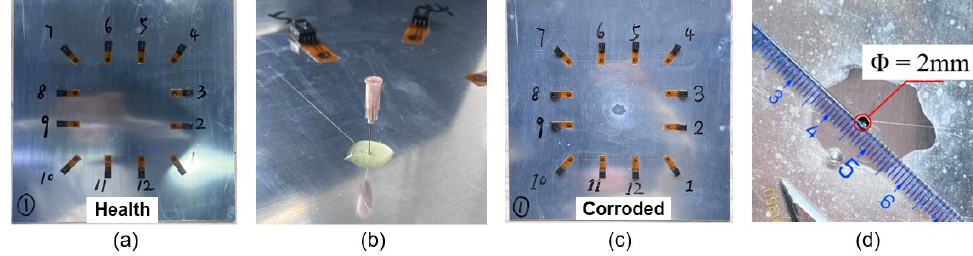
Figure 5. The manufacture process: ( a ) Undamaged specimen. ( b ) Corrosion process. ( c ) Damaged specimen. ( d ) Enlarged view of simulated pitting corrosion.